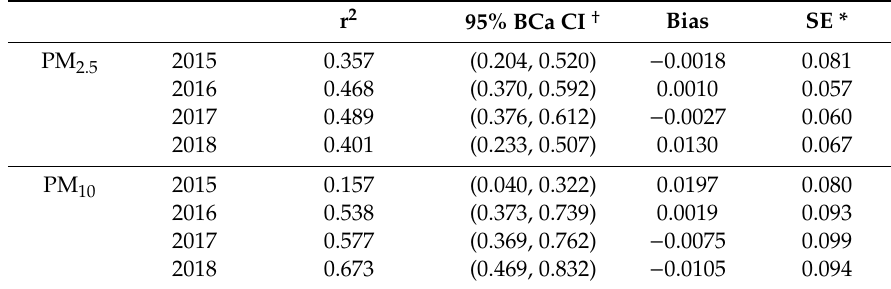
Table 3. Bootstrapped estimates of associations between Network and regulatory mean 24-h average PM 2.5 and PM 10 measurements from ordinary least squares linear regressions.